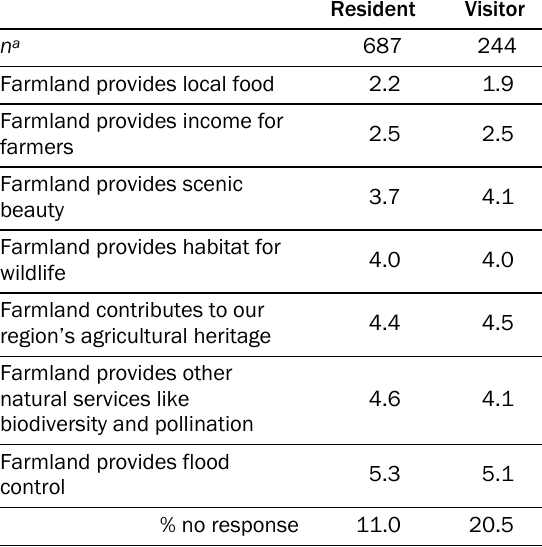
Table 7. Average Ranking of